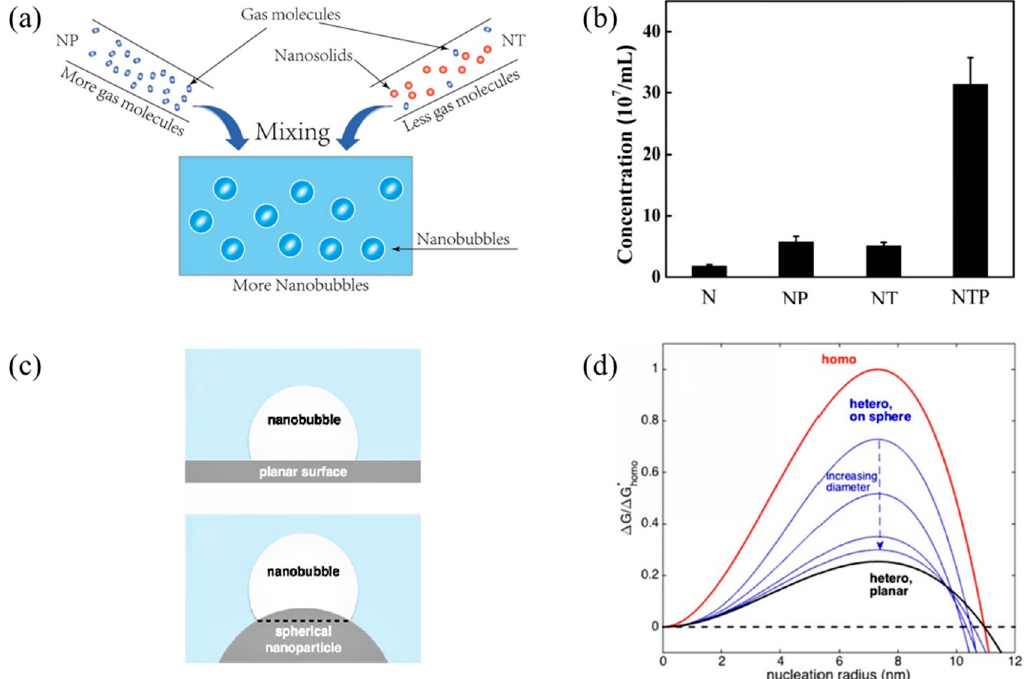
Figure 4. ( a ) A nanoparticles and nanobubbles mixed solution, ( b ) the effect of nanoparticles on nanobubbles, ( c ) the nucleation of nanobubbles at planar and solid/gas interfaces and ( d ) the energy barrier that prevents nucleation for homogeneous nucleation, which shows that nucleation on smaller nanoparticles requires more energy [110,115]. (N—Na 2 CO 3 ; NP—pressurized N; NT—Na 2 CO 3+ titanium dioxide; NTP—pressurized NT), reprinted with permission from Ref. [110] and Ref.[115].